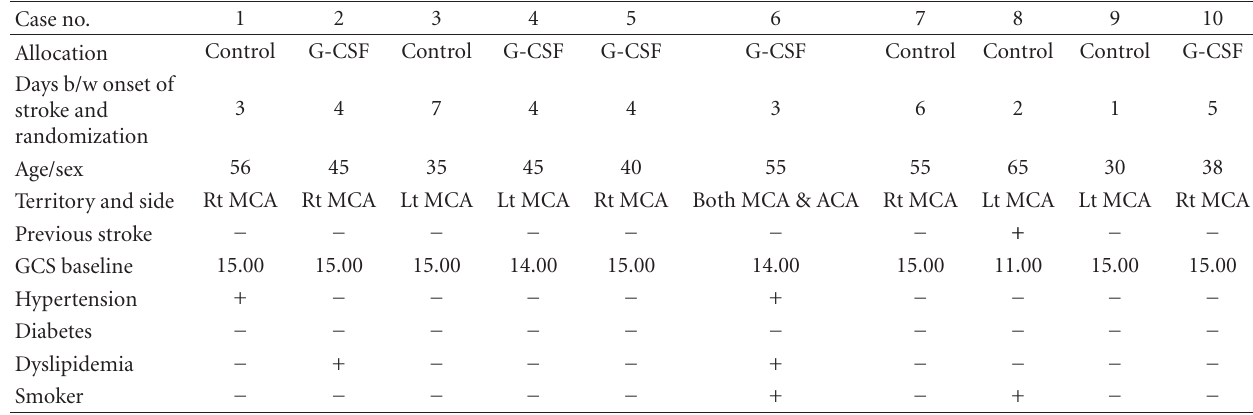
Table 2: Patient’s characteristics.